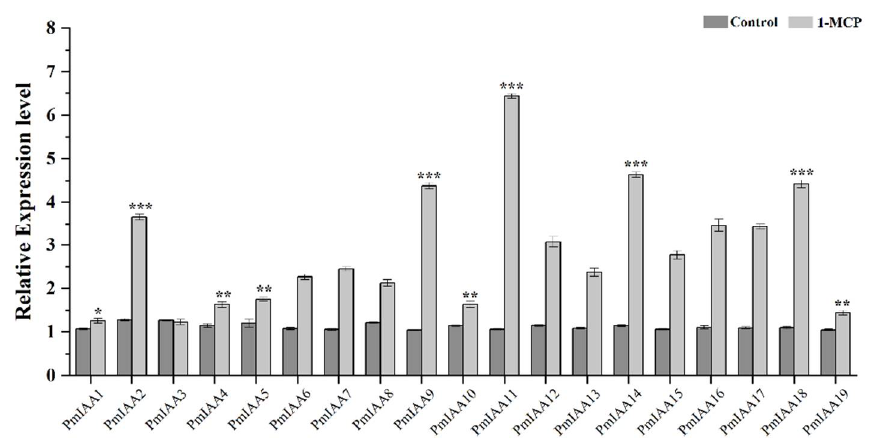
Figure 6. The expression of PmIAA genes in response to 1-MCP treatment was analyzed through qRT-PCR. The expression levels of PmIAA genes in control seedlings were set to a value of 1. The error bar represents the standard error of their biological repeats. Significant differences between control and treated samples are indicated in asterisk (*). The sign * represents p ≤ 0.05, ** represents p ≤ 0.01 and *** represents p ≤ 0.001.